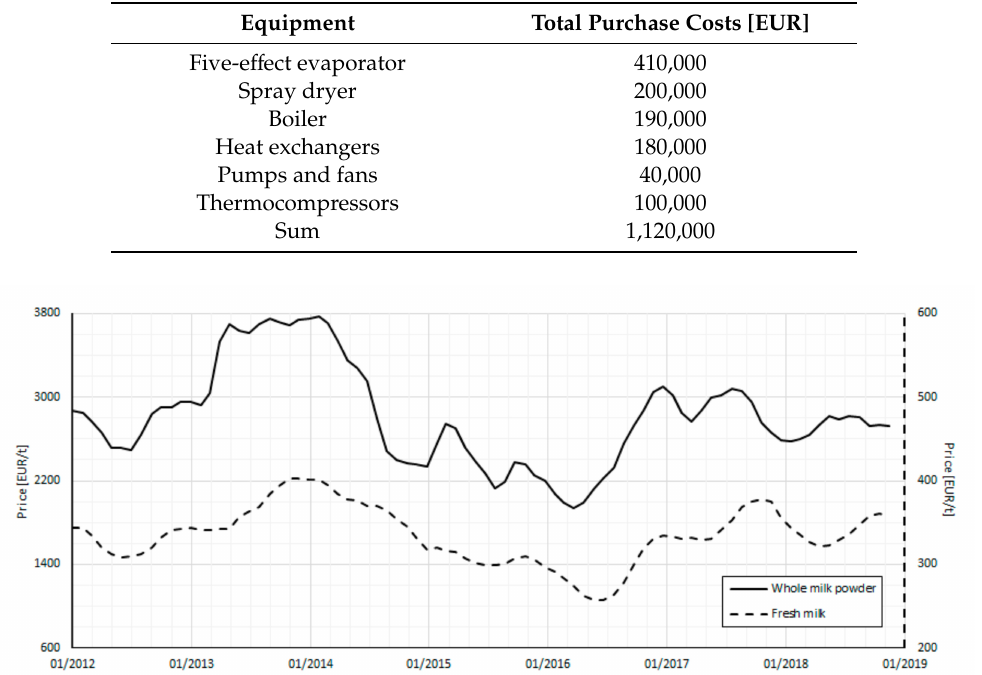
Table 6. Required investment breakdown.